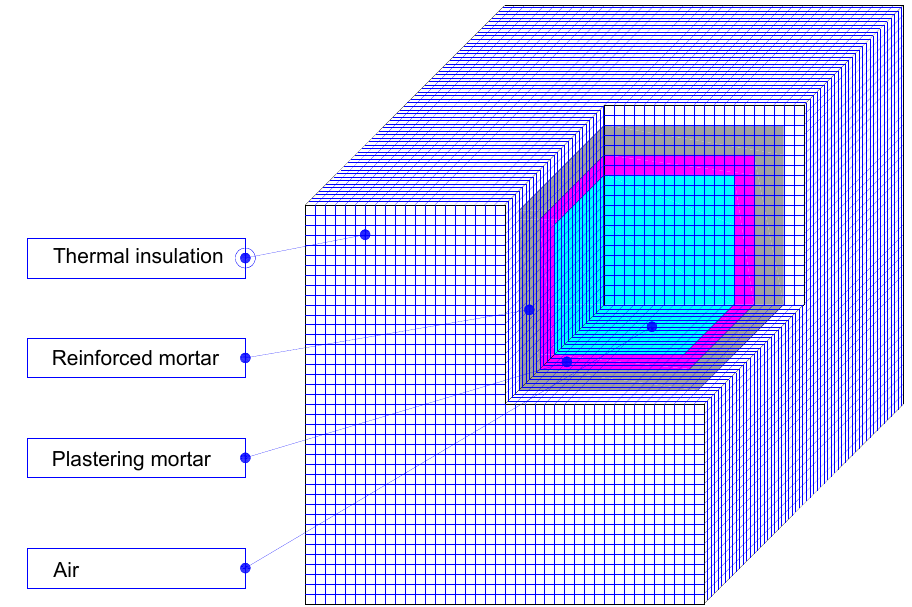
Figure 10. Numerical thermal model pilot test cell .